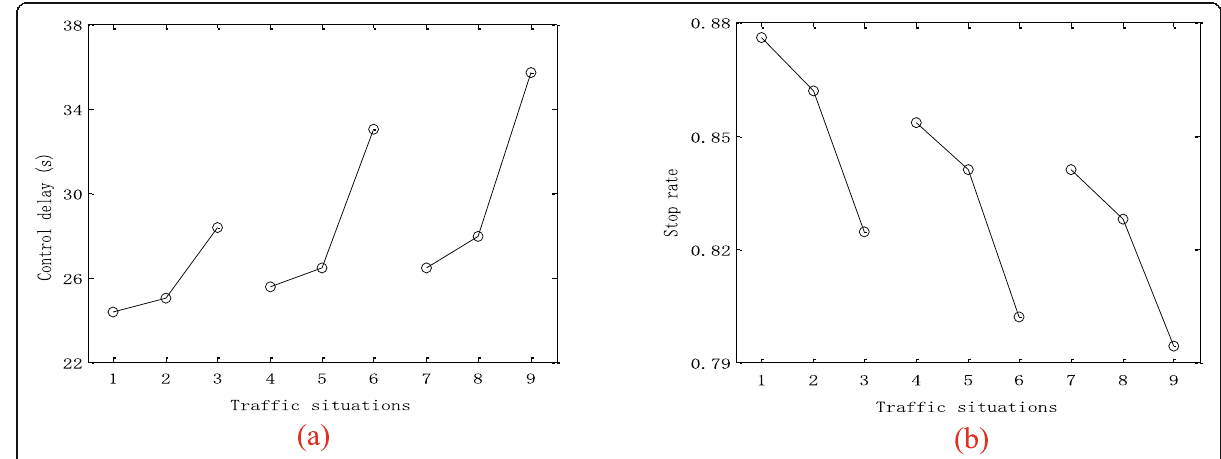
Fig. 4 Comparison of vehicle delays and stop rates of different mixed proportions of electric vehicles with the same road section speed. a Comparison of vehicle delay. b Comparison of vehicle stop